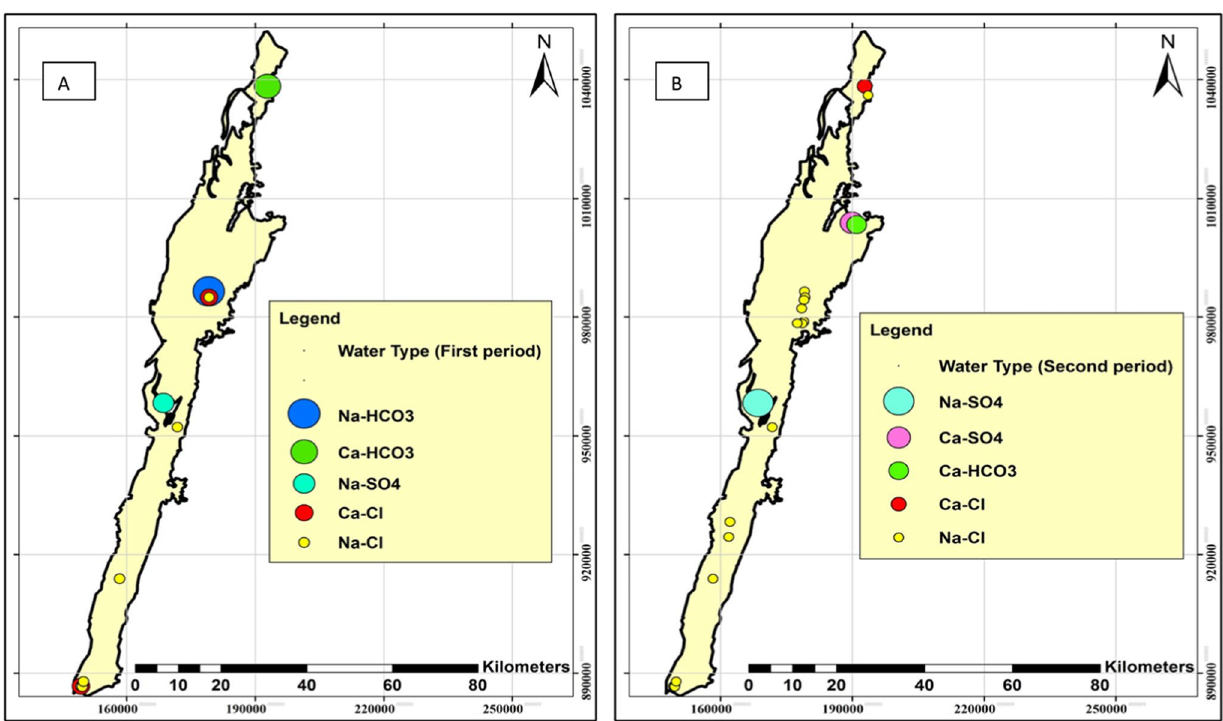
Fig. 7 Spatial distributions of groundwater type of the alluvial aquifer in two sampling campaign in A spring season (April–May). B autumn season (August–September). The size of circle indicates the salinity of